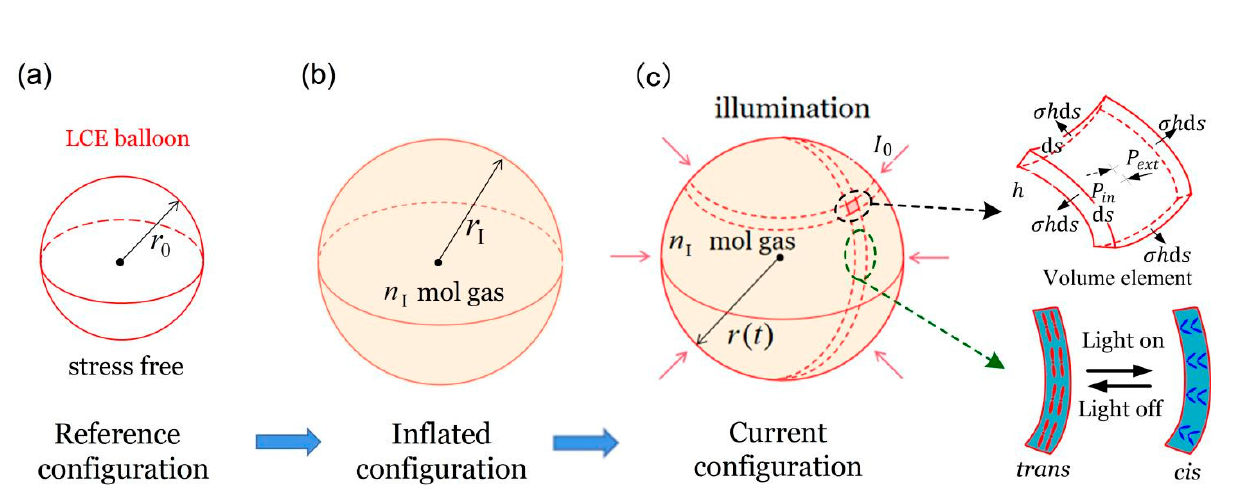
Figure 1. Schematic diagram of a spherical light-powered beating LCE balloon. ( a ) Reference state in stress-free state. ( b ) The balloon is inflated by gas with amount of substance n I to the balanced state, namely the initial state. ( c ) The instant state of the balloon as a function of the radius r ( t ) under periodic lighting conditions.